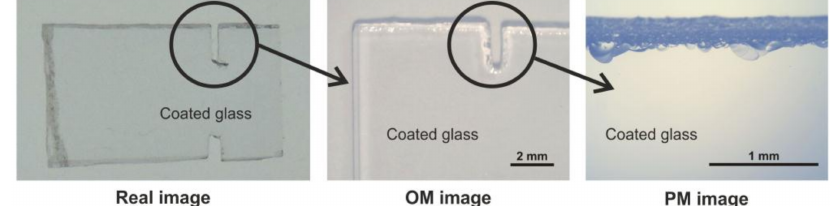
Figure 5. Photograph, OM image and PM image of a glass slide piece coated with La(Ac) 3 doped silica after the treatment in the Kesternich